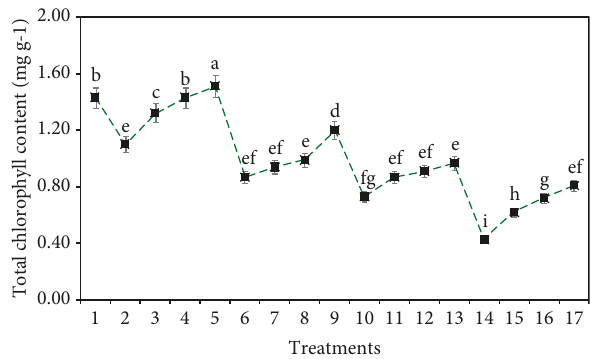
Figure 10: Impact of biosorbed water by various biosorbents (orange peels, pomegranate peels, and peanut peels) on total chlorophyll content of mung bean after 7 days of seed germination. T1, negative control; T2, 50mg kg − 1 ; T3, pomegranate peel bio-